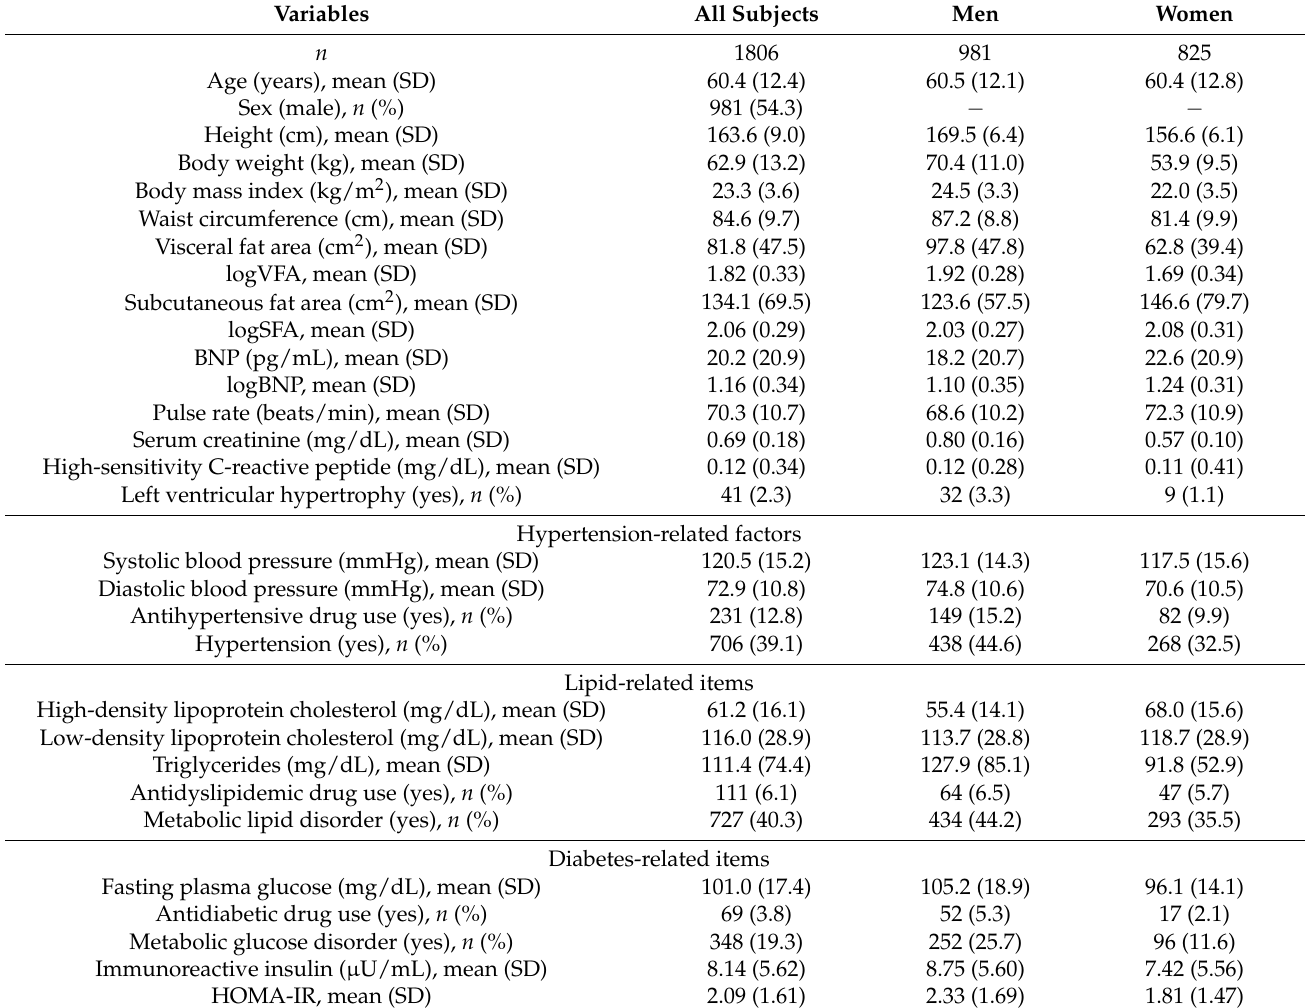
Figure 1. Study flowchart. Table 1. Clinical characteristics of study participants.